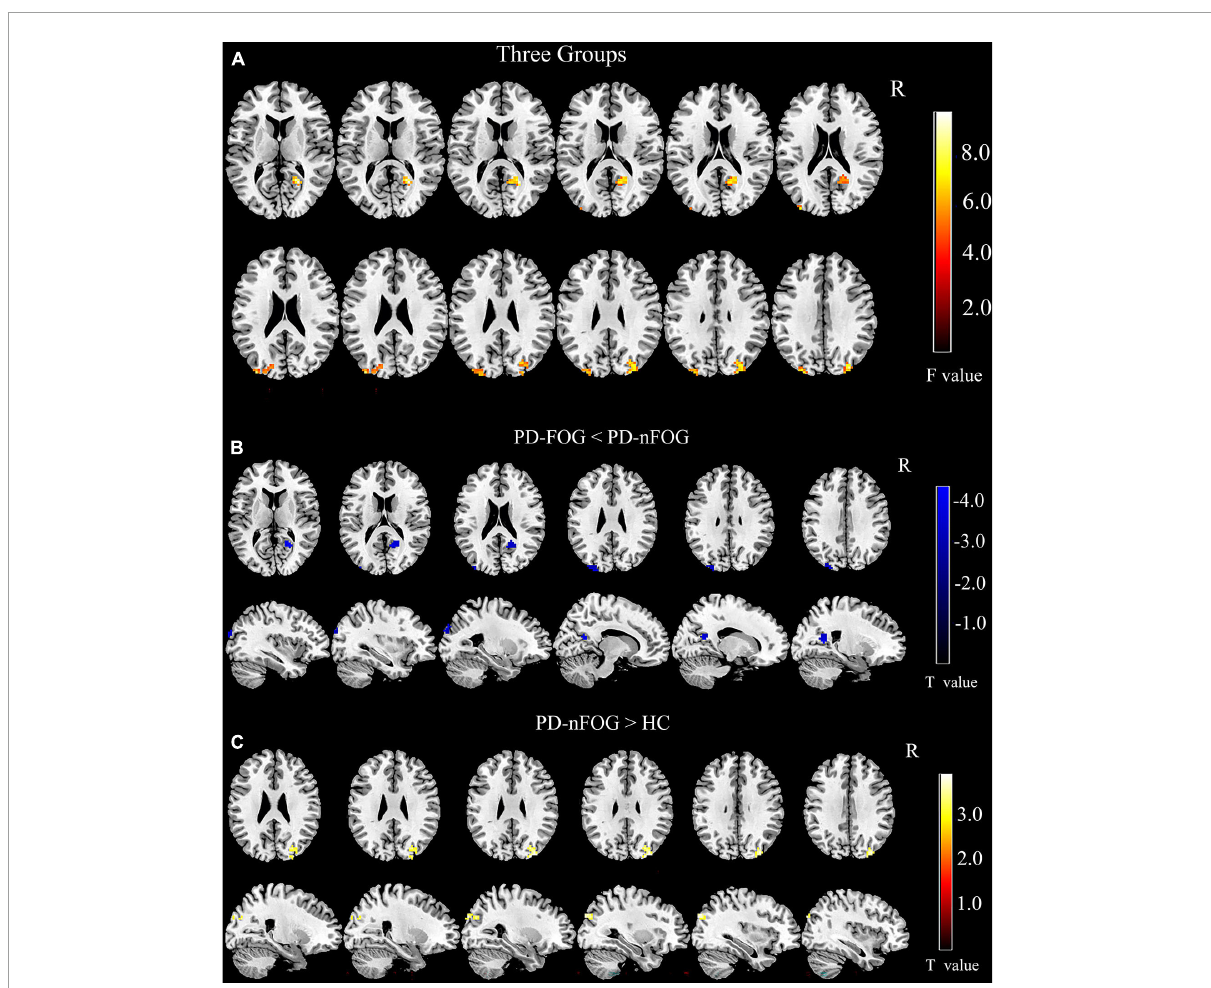
FIGURE3 Comparison of Seed-Based Resting State Functional Connectivity. (A) Comparison of rs-FC among three groups (voxel threshold p < 0.01, clusters AlphaSim corrected p < 0.05 and cluster size > 41 voxels); (B) Comparison of rs-FC between PD-FOG and PD-nFOG (voxel threshold p < 0.01, clusters AlphaSim corrected p < 0.01 and cluster size > 33 voxels); (C) Comparison of rs-FC between PD-nFOG and HC (voxel threshold p < 0.01, clusters AlphaSim corrected p < 0.01 and cluster size > 41